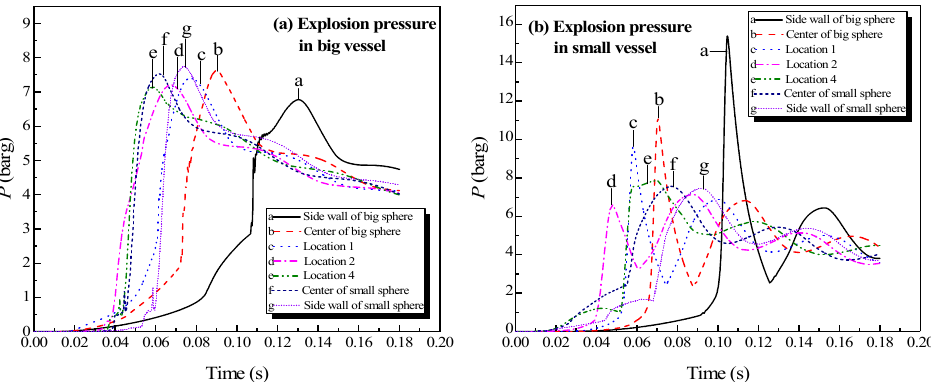
Figure 12. Natural gas explosion pressure versus time in the large and small vessels at di ff erent ignition positions.